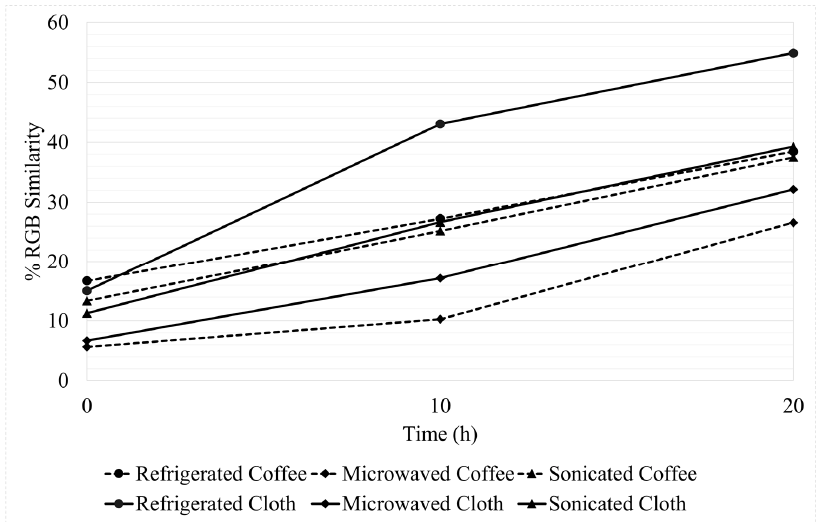
Figure 8. Percent RGB similarity as a function of time.